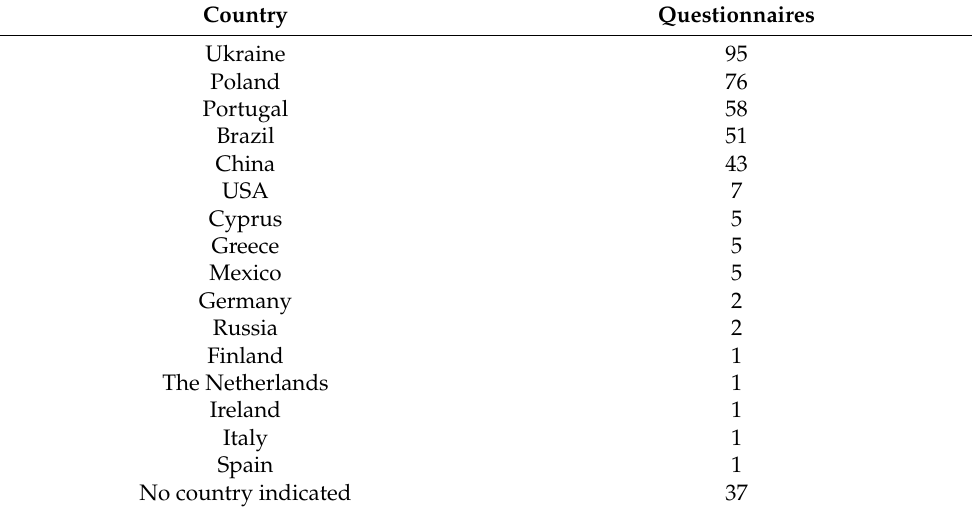
Table 2. The number of questionnaires by countries of questionees.